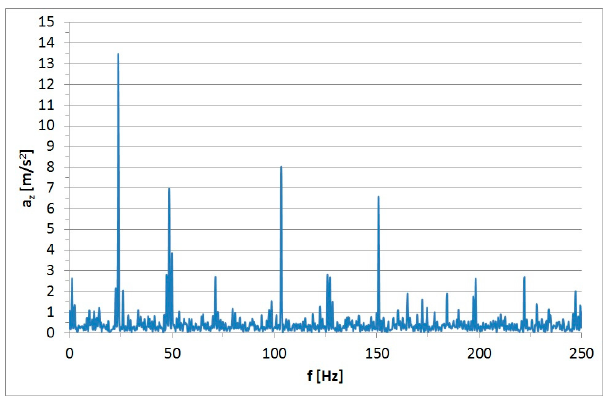
Figure 2. Amplitude-frequency spectrum (limited to 250 Hz) of the vibration acceleration of a forklift frame. Drive motor speed: 800 rpm.